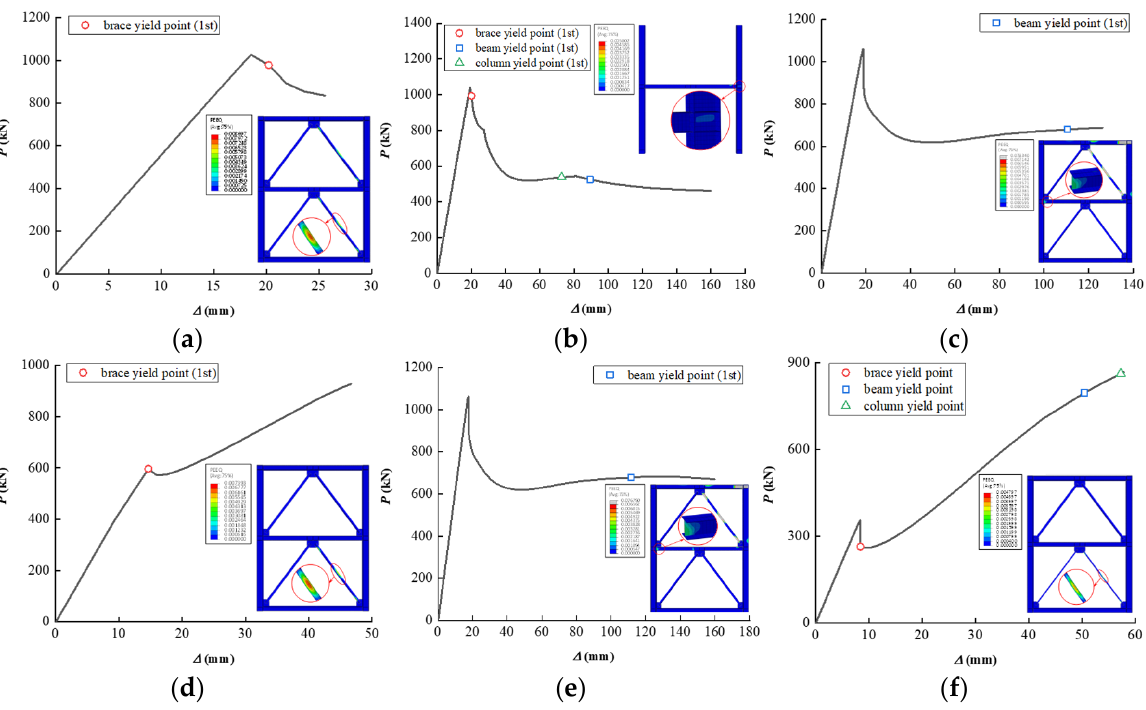
Figure A6. The predicted PEEQ distributions of a typical floor with η = 0.3. ( a ) case 33, the basic model obtained by the proposed method; ( b ) case 36, smaller column web section area; ( c ) case 39, thicker braces; ( d ) case 42, thinner braces; ( e ) case 45, larger external brace diameter; ( f ) case 48, smaller external brace diameter than in the basic model.